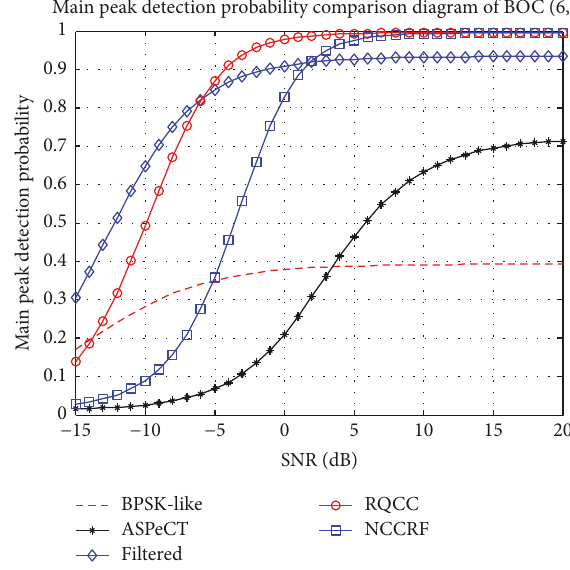
Figure 13: The MPDR comparison of BOC ( 2,2 ). Main peak detection probability comparison diagram of BOC (8,4)